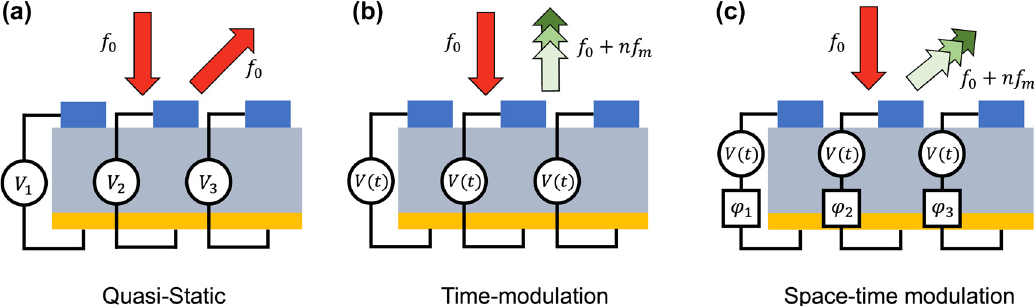
is reflected from an electrically programmable metasurface. (a) In the quasi-static operation regime, Figure 1: Incident light of frequency f 0 the timescale of reconfiguration is smaller than the linewidth of the incident laser, such that the frequency of the reflected light remains , allowing the generation unchanged. (b) In the time-modulated regime, metasurface elements are collectively driven at a high frequency, f m + nf . (c) In a space-time modulated metasurface, a phase offset 𝜑 is of higher order harmonics in the reflected light with frequencies f 0 m i added between the time-modulated signals of individual metasurface elements using external phase shifters. This enables shaping of frequency-modulated reflected